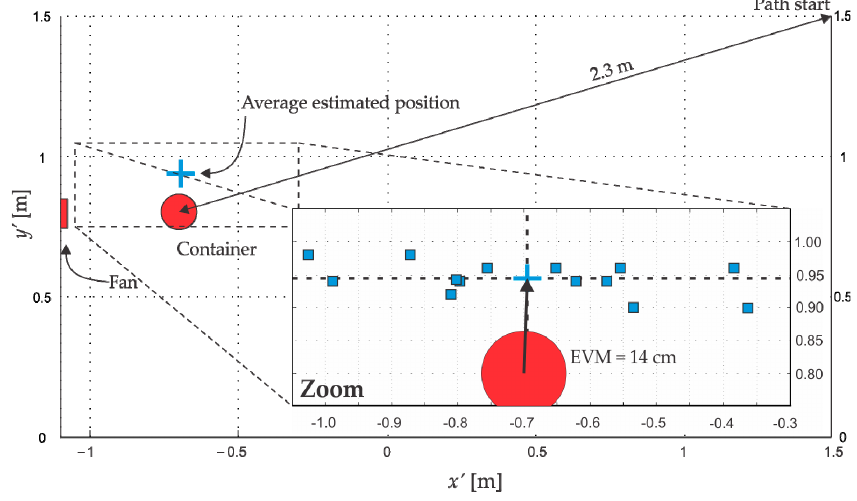
Figure 11. Estimated positions of the container for the 14 paths using Equation (13) and C α = 0.9 C max in the region of steeper slope. The cross represents the average estimated position. Container dimensions in proportion.